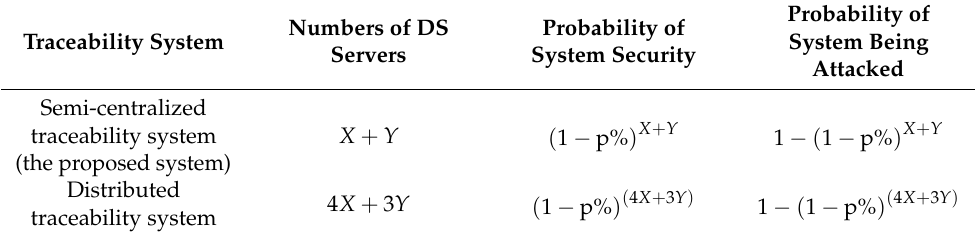
Table 5. Information security of different traceability systems.